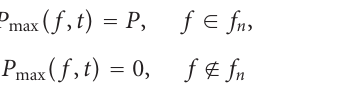
Figure 1 illustrated the MIMO cooperative